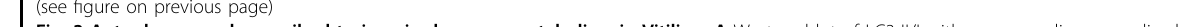
Fig. 3 Autophagy can be ascribed to impaired energy metabolism in Vitiligo. A Western blot of LC3-II/I with corresponding normalized densitometric values on lysates of vitiligo melanocytes after treatment with NAC (5 and 10 mM) for 24 h. A representative blot of three independent experiments is shown; B Western blot of Beclin I and SQSTM1/p62 with normalized densitometric analysis on vitiligo melanocytes treated with NAC (5 and 10 mM) for 24 h. Representative blots of three independent experiments are shown; C Immuno fl uorescence of LC3 expression (red) and corresponding quantitative analysis of the number of LC3 positive puncta per cell (n = at least 150 cells per group) in vitiligo melanocytes treated or not with NAC (5 mM) for 24 h. Nuclei were counterstained with DAPI. Boxes show the enlarged view of the selected cells. The arrows point at LC3 positive dots. Scale bars: 10 μ m. A representative vitiligo melanocyte culture is shown; D Western blot of pS6K, LC3-II/I and Beclin I with corresponding normalized densitometric values on lysates of vitiligo melanocytes pretreated with Rapamycin (1 and 5 uM) for two hours followed by NAC-treatment (5 and 10 mM) for 24 h. A representative blot of three independent experiments is shown; E Western blot of pAMPK with corresponding values of normalized densitometric analysis on cell lysates of vitiligo melanocytes after treatment with NAC (5 mM) and t-BHP (100uM) for 24 h. A representative blot of three independent experiments is shown; F Normalized mRNA transcripts of autophagy genes Atg5, Atg7, Atg8 following t-BHP treatment (100uM) for 24 h in normal melanocytes (NHM n = 3); G Immuno fl uorescence analysis of LC3 (red) and corresponding quantitative analysis of the number of LC3 positive puncta per cell ( n = at least 150 cells per group) in t-BHP-treated (100 uM for 24 h) normal melanocytes. Nuclei were counterstained with DAPI. Scale bar: 10 μ m. A representative normal melanocyte culture treated with t-BHP is shown; H Immuno fl uorescence and corresponding normalized fl uorescence intensity of pS6K (red) in t-BHP-treated (100 uM for 24 h) normal melanocytes. Nuclei were counterstained with DAPI. A representative normal melanocyte culture treated with t-BHP is shown. Scale bar: 10 μ m; I Western blot of LC3-II/I and Beclin I with normalized densitometric analysis on vitiligo melanocytes treated with t-BHP (100 uM) for 24 h. Representative blots of three independent experiments are shown. pAMPK, phospho-adenosine monophosphate (AMP)-activated protein kinase; Atg5 , autophagy related 5; Atg7 , autophagy related 7; Atg8 , autophagy related 8; LC3-I/II, (microtubule-associated protein 1) light chain 3; NAC, N-acetyl-L-cystein; NHMs, normal human melanocytes; SQSTM1/p62, sequestosome-1; t-BHP, tert-butyl hydroperoxide; pS6K, Phospho S6 kinase; VHMs, vitiligo human